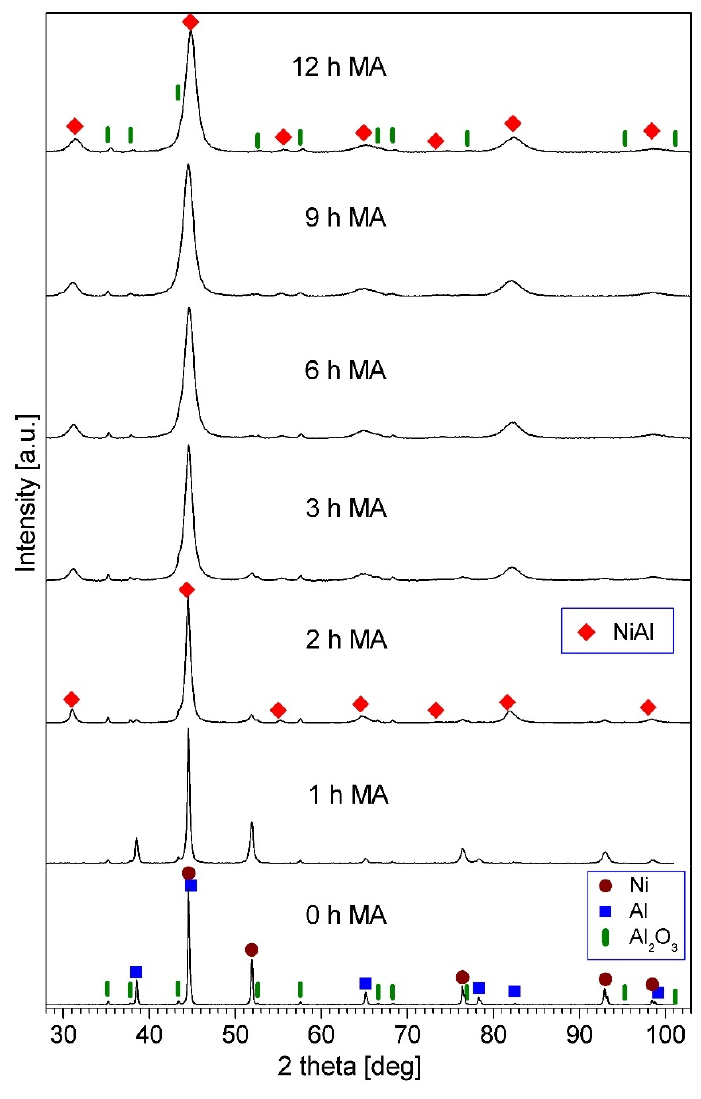
Figure 3. XRD patterns of the (Ni-50at.%Al) + 10wt.%Al 2 O 3 powder mixture milled for the times quoted. mechanical alloying: (a) NiAl-10%Al 2 O 3 powder; (b) NiAl-20%Al 2 O 3 powder. The observation reveals that the composite powders are characterized by the tendency to create spherical agglomerates with sizes ranging from below 1 µm up to 20 µm. The density measured using a helium pycnometer for NiAl-10%Al 2 O 3 powder was 5.4571 g/cm 3 , while for the NiAl-20%Al 2 O 3 powder it was 5.1858 g/cm 3 .